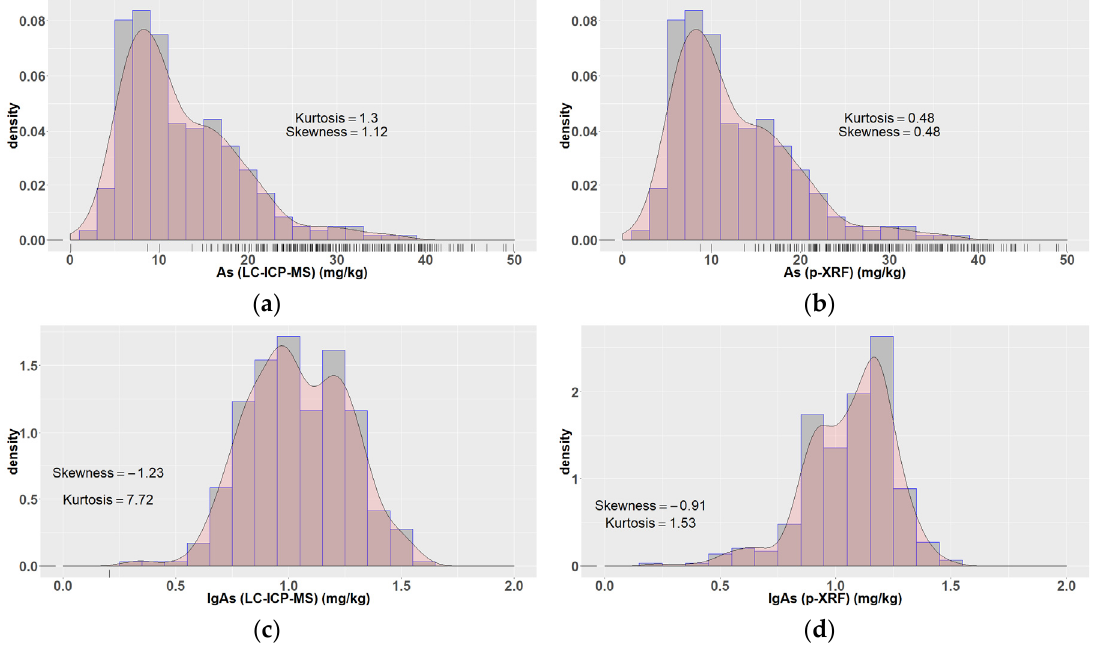
Figure 10. Histogram of the original data of content of As measured by LC-ICP-MS ( a ) and p-XRF ( b ), and log10()-transformed content of As measured by LC-ICP-MS ( c ) and p-XRF ( d ).